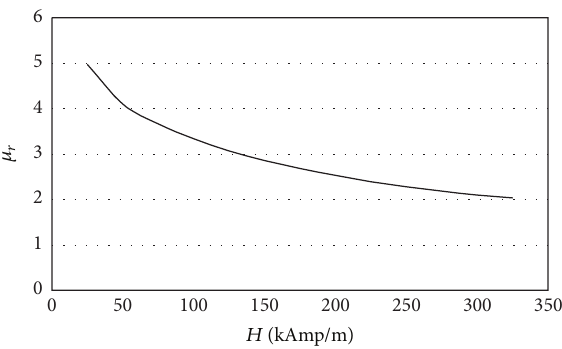
Figure 7: The relative magnetic permeability versus applied mag- netic field